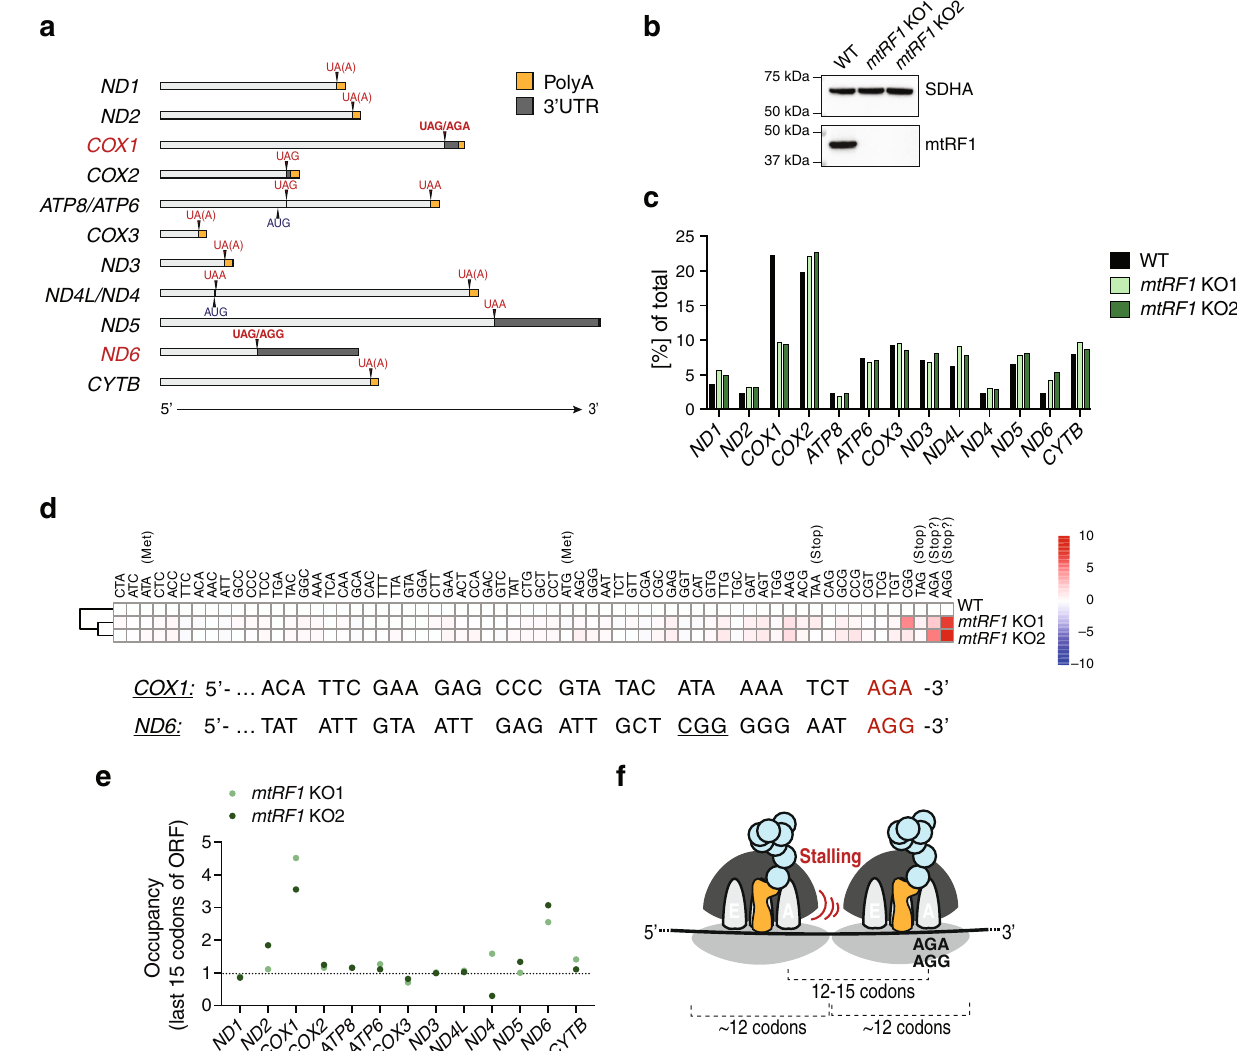
Fig.1|Mitoribosomesstallattheendsof COX1 and ND6 transcriptsin mtRF1 KO cells. a Schematic representation of human mitochondrial transcripts including polyA tails (orange), 3 ′ untranslated regions (3 ′ UTRs) (dark gray), stop codons (red), and start codons of bicistronic transcripts (dark blue). Relative lengths of regions are depicted. b Western blot con fi rming the generation of mtRF1 KO cells. 40 µ g mitolysates were loaded. Two different clones are shown (KO1 and KO2). Loading was assessed by SDHA detection. A representative blot of n =3 indepen- dent experiments is depicted. c – e Analysis of ribosome pro fi ling data of WT and mtRF1 KO cells. c Occupancy of mitoribosomes on each transcript relative to the total occupancy on all transcripts. d Upper panel: Codon counts relative to